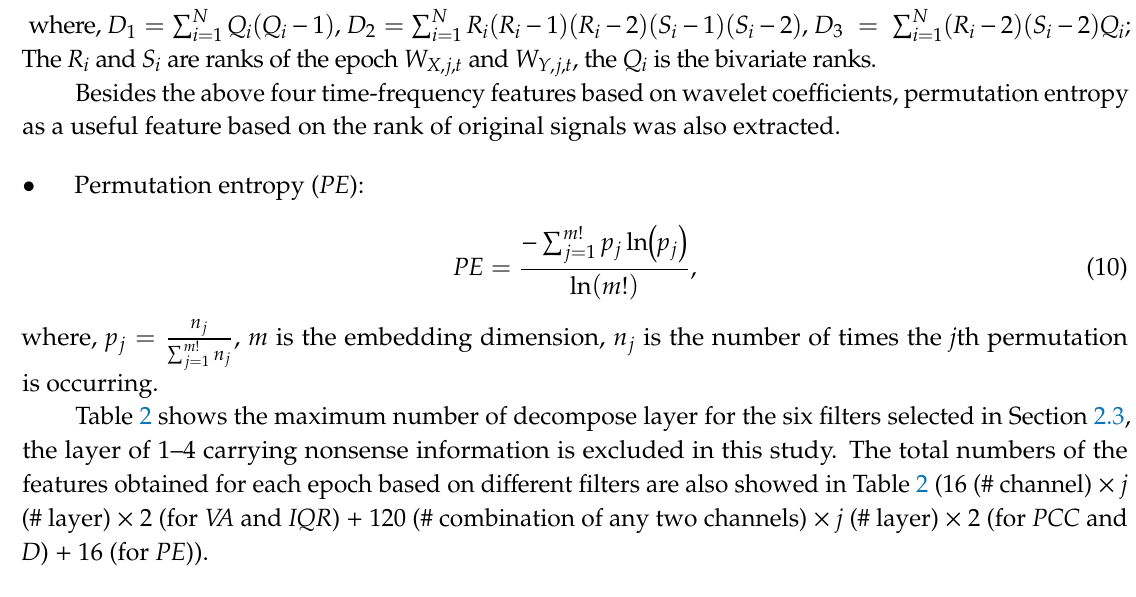
Table 2. The maximum decompose layer for di ff erent wavelet